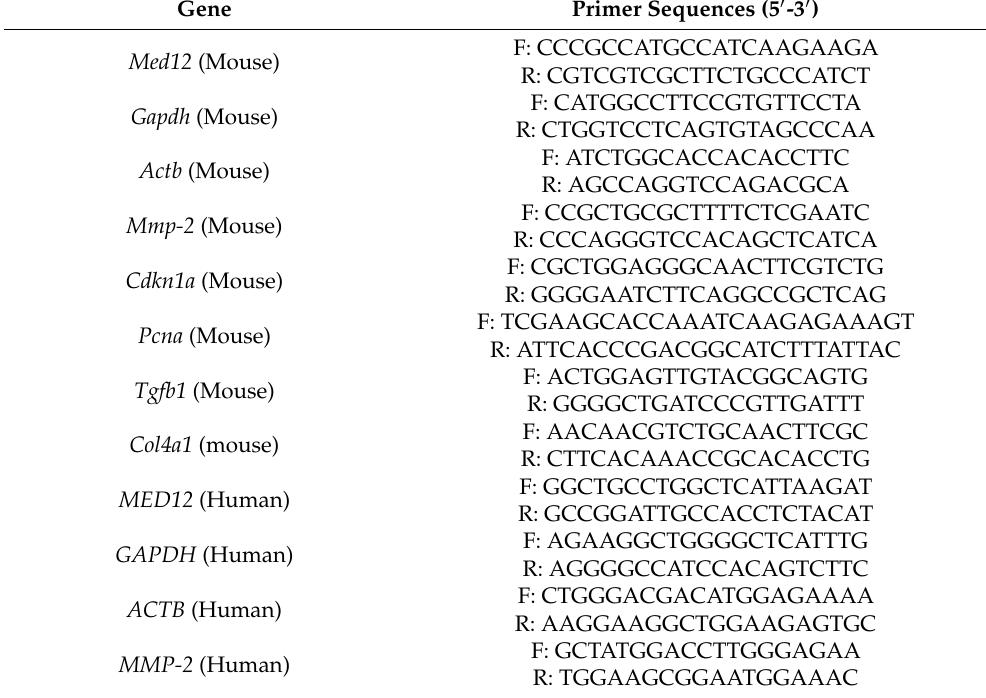
Table 1. Primer sequences of target genes in